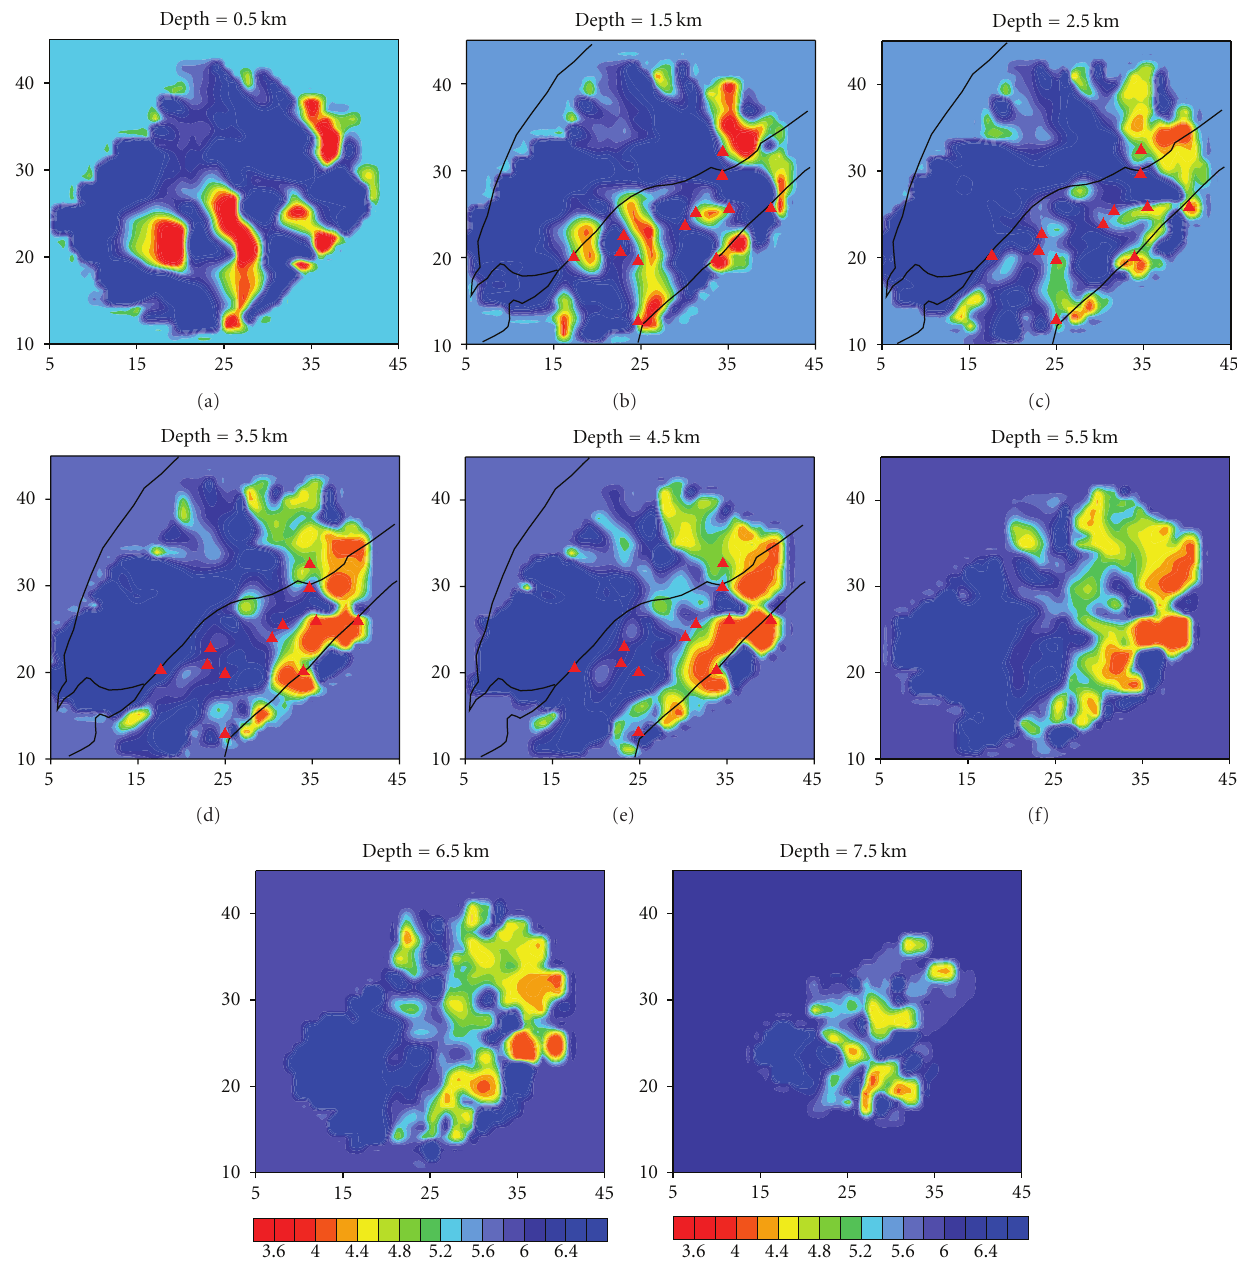
Figure 5: P wave velocity models at di ff erent depth. The depth of each layer is shown at the upper part of the map. Red triangles represent the stations. The P wave velocity scale is shown on the bottom. Color scale is absolute P wave velocity (km/s). Background velocity near the edges denotes the initial 1-D velocity model. The coordinates are in